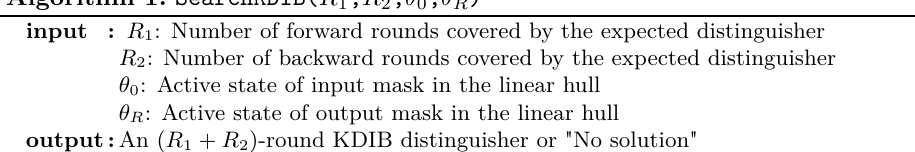
Algorithm 1: SearchKDIB( R 1 , R 2 , θ 0 , θ R